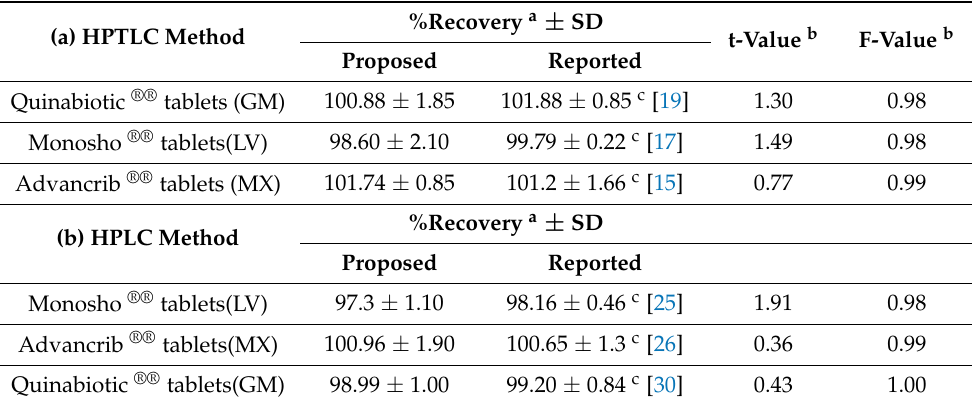
Table 3. Determination of GM, LV, and MX in tablet dosage forms using (a) the proposed HPTLC in comparison with reported HPTLC methods and (b) the proposed HPLC in comparison with reported HPLC methods.